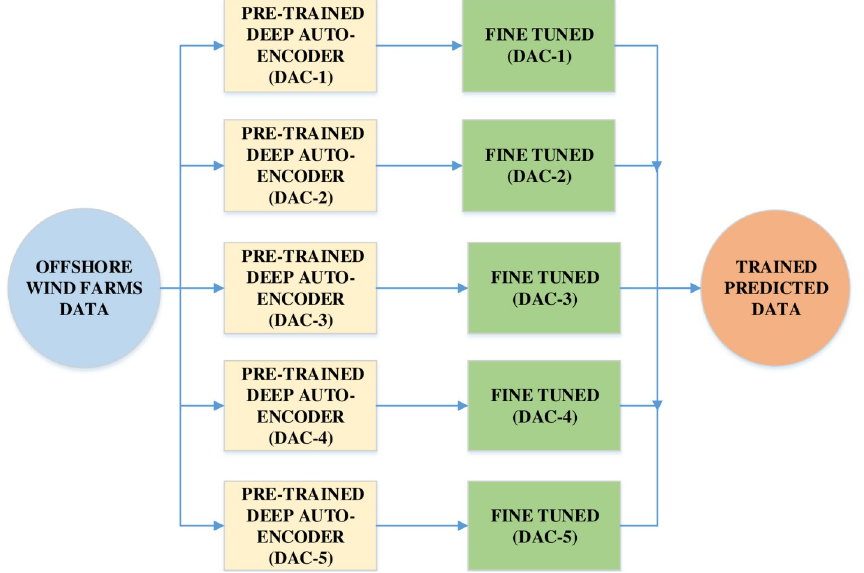
Fig 2. Dataflow graph of deep auto-encoders used in pre-processing of wind turbine datasets before actual wind power forecasting.